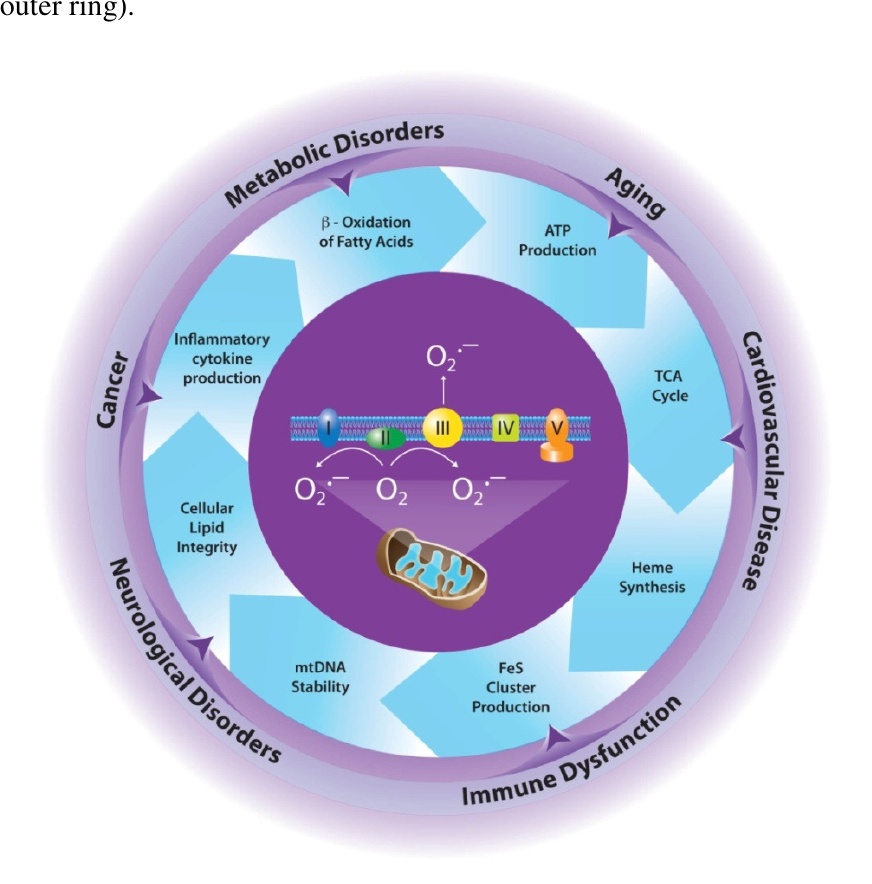
Figure 1. Mitochondria are the major source of ROS in the cell through superoxide production at complexes I and III of the electron transport chain (center). Excessive ROS production can damage different components of mitochondrial metabolic pathways, resulting in altered mitochondrial function and an imbalance in cellular homeostasis (inner ring). Diminished mitochondrial function leads to the development of numerous diseases (outer